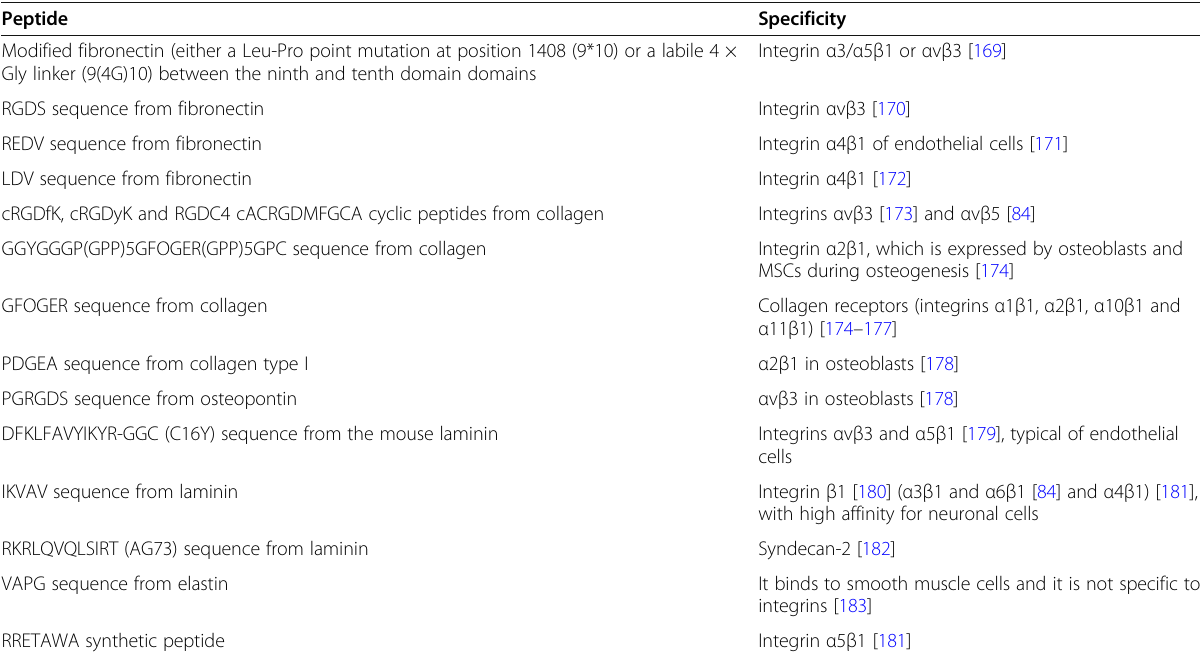
Table 2 ECM-derived cell adhesion peptides. Most used peptides derived from ECM proteins and targeting specific cell types/cell